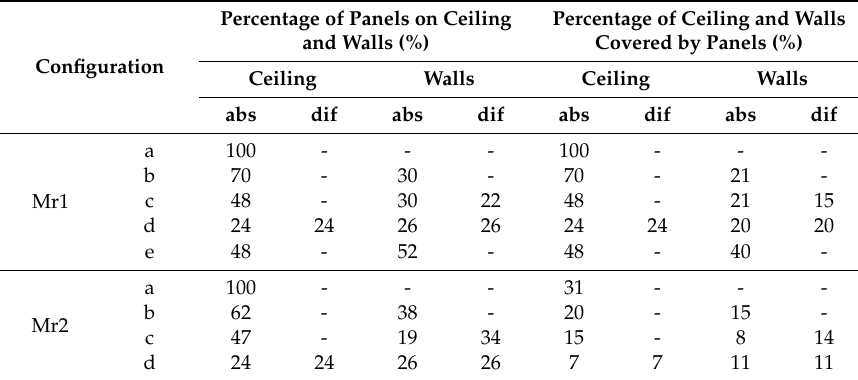
Table 1. Percentages of acoustic panels on ceiling and walls and percentages of ceiling and walls covered by acoustic panels (abs and di ff ), for the di ff erent configurations shown in Figures 5 and 6, in Mr1 and Mr2,